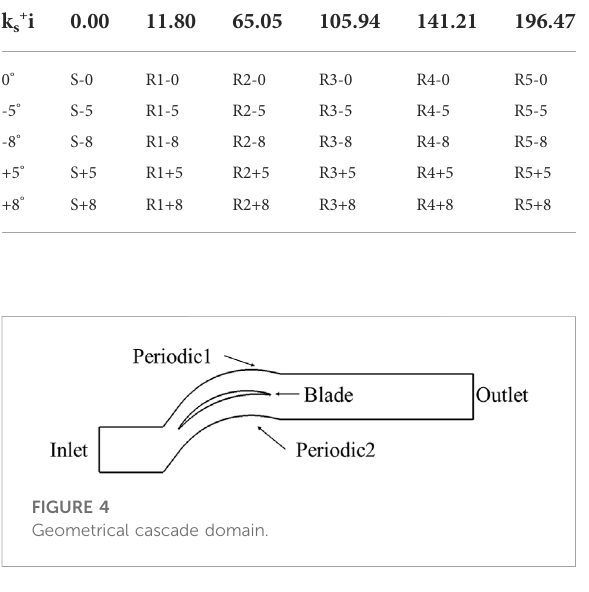
TABLE 2 Incoming attack angle ( i ) and wall roughness ( k s + ).